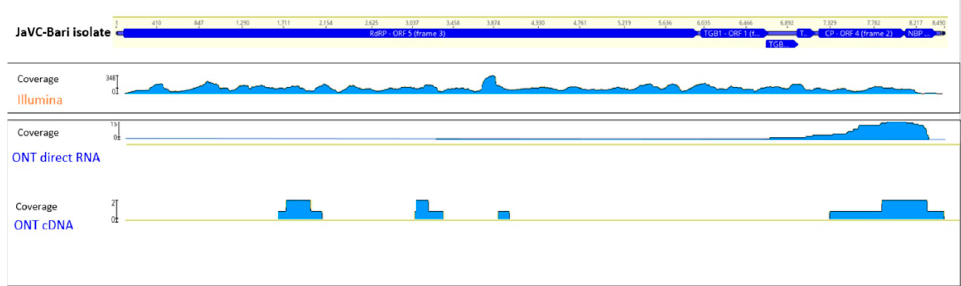
Figure 1. Genomic organization of JaVC. Distribution and respective coverage of the reads obtained from the three techniques along the genome of JaVC-Bari isolate.